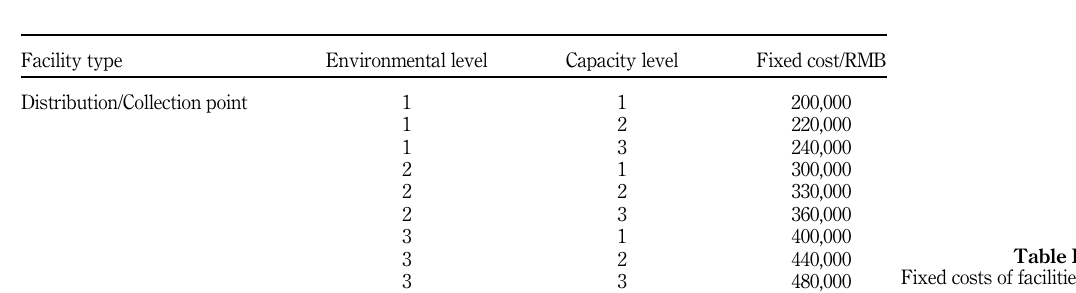
Table I. Fixed costs of facilities